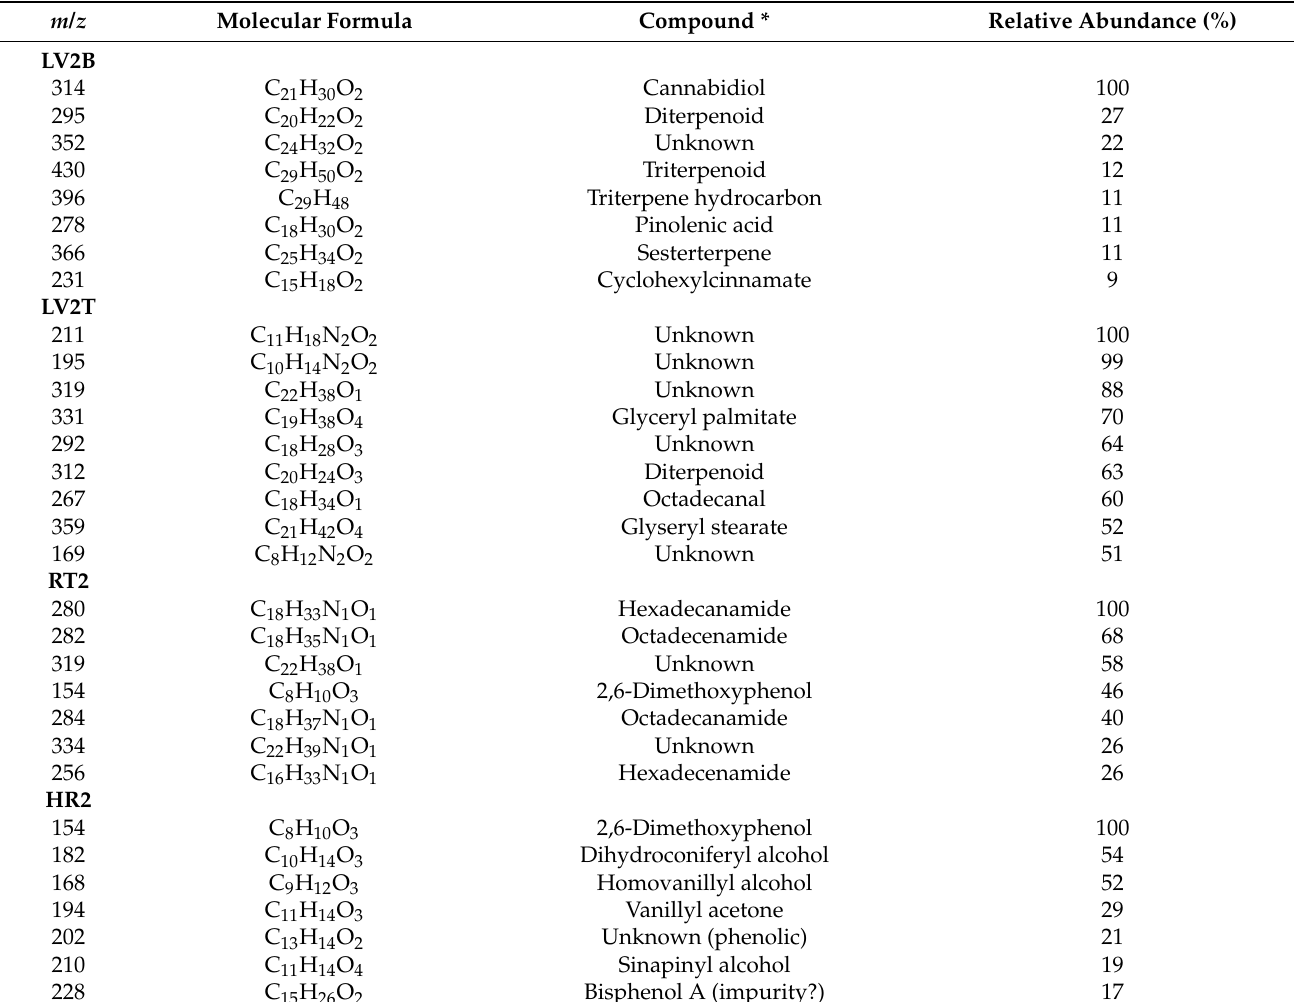
Table 12. Most abundant compounds detected in LV2B, LV2T, RT2, and HR2 with APPI FT-ICR MS. m / z Molecular